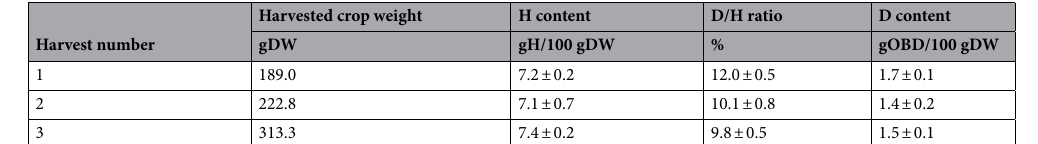
Table 7. Characterization of D-labelled soybean. H, hydrogen. D, deuterium. DW, dry weight. OBD, organically bound deuterium. Values are presented as mean ± standard deviation.